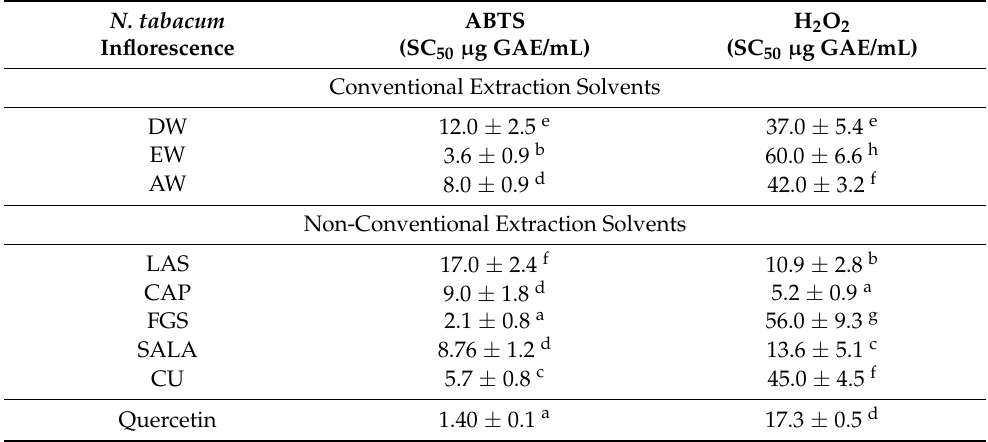
Table 4. Antioxidant activity of Nicotiana tabacum var. Virginia inflorescence wastes powder